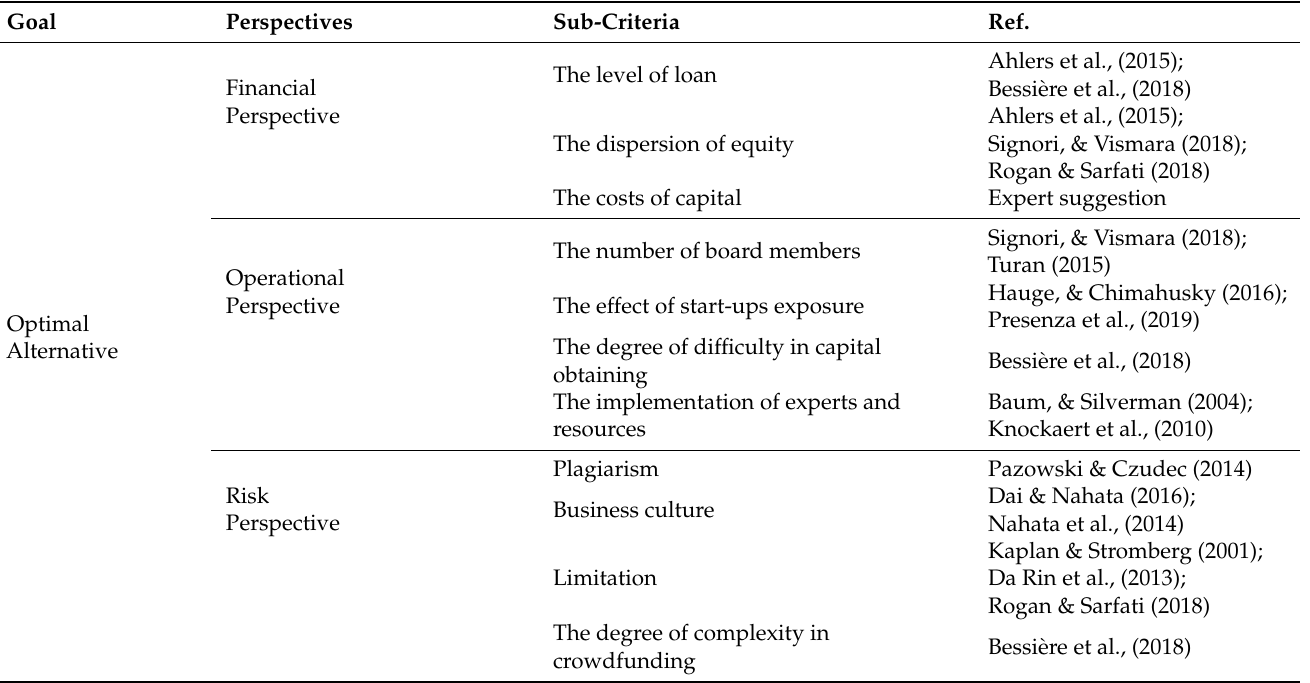
Figure 3. The expert network decision support model. Table 1. The perspectives and